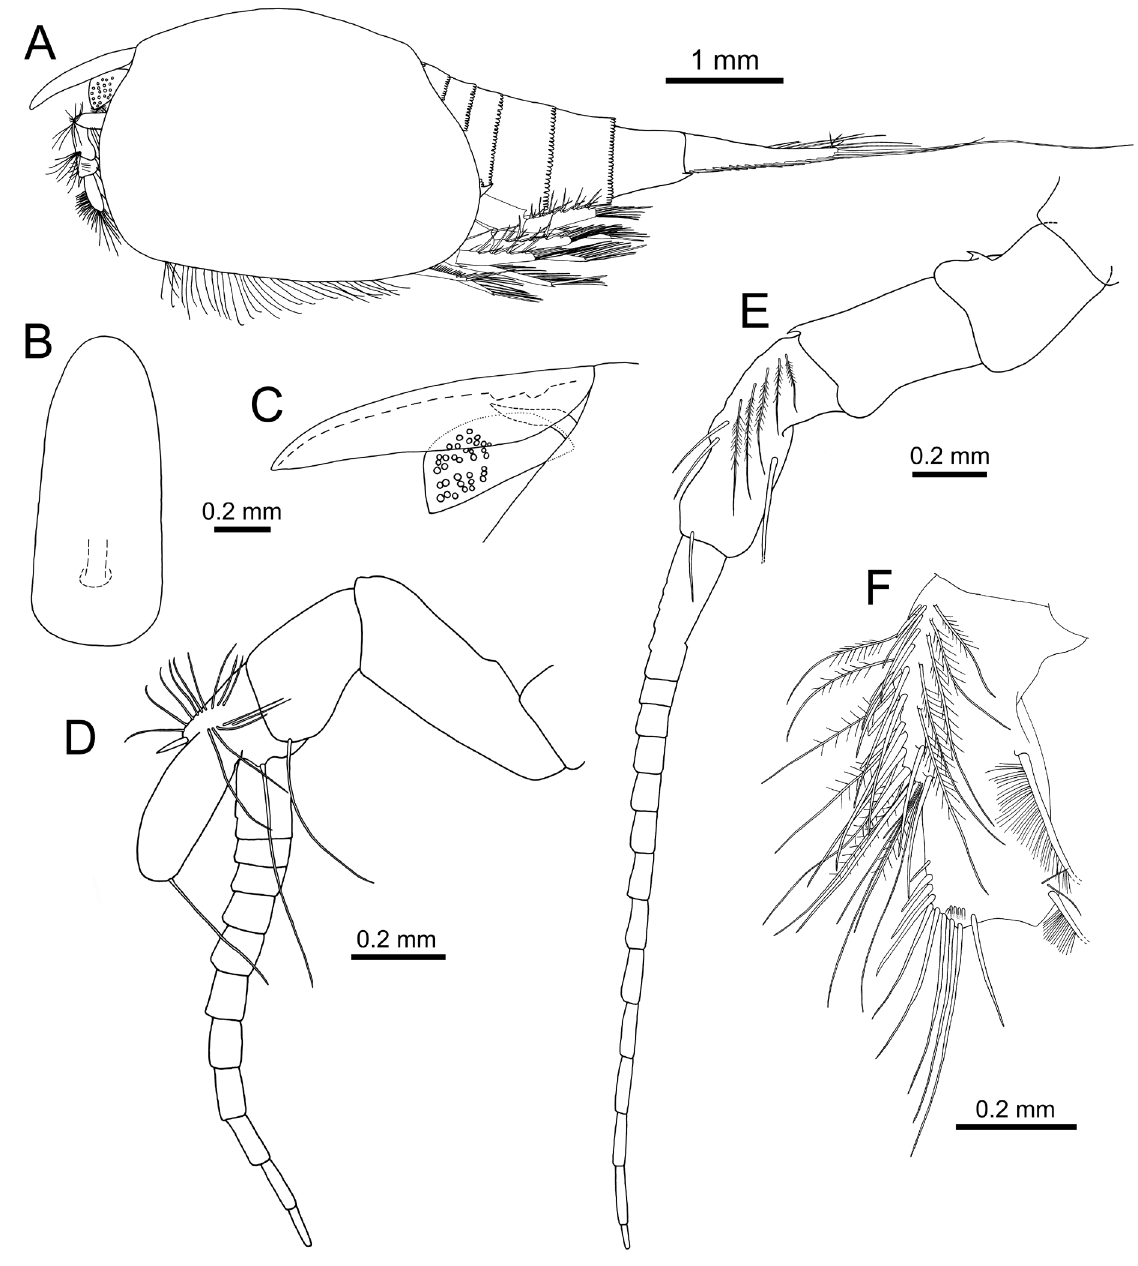
Fig. 6. Nebalia abyssicola Fage, 1929. Ovigerous female (DBUA0002350.01.A). A . Complete specimen, lateral view. B . Rostrum, dorsal view. C . Rostrum and eye, lateral view. D . Antennule, lateral view. E . Antenna, lateral view. F . Antenna, third article, lateral view. B–C: same scale bar; D–E: only selected setae